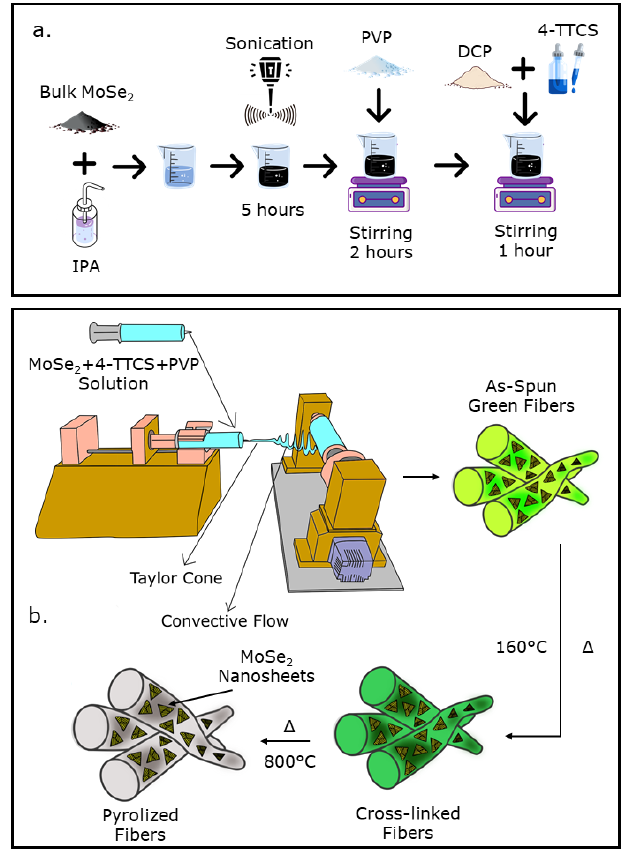
Figure 1. Solution preparation process for ( a ) PVP/SiOC/MoSe 2 fiber mat; ( b ) schematic showing electrospinning process for the fabrication of the PVP/SiOC/MoSe 2 composite fiber mats.